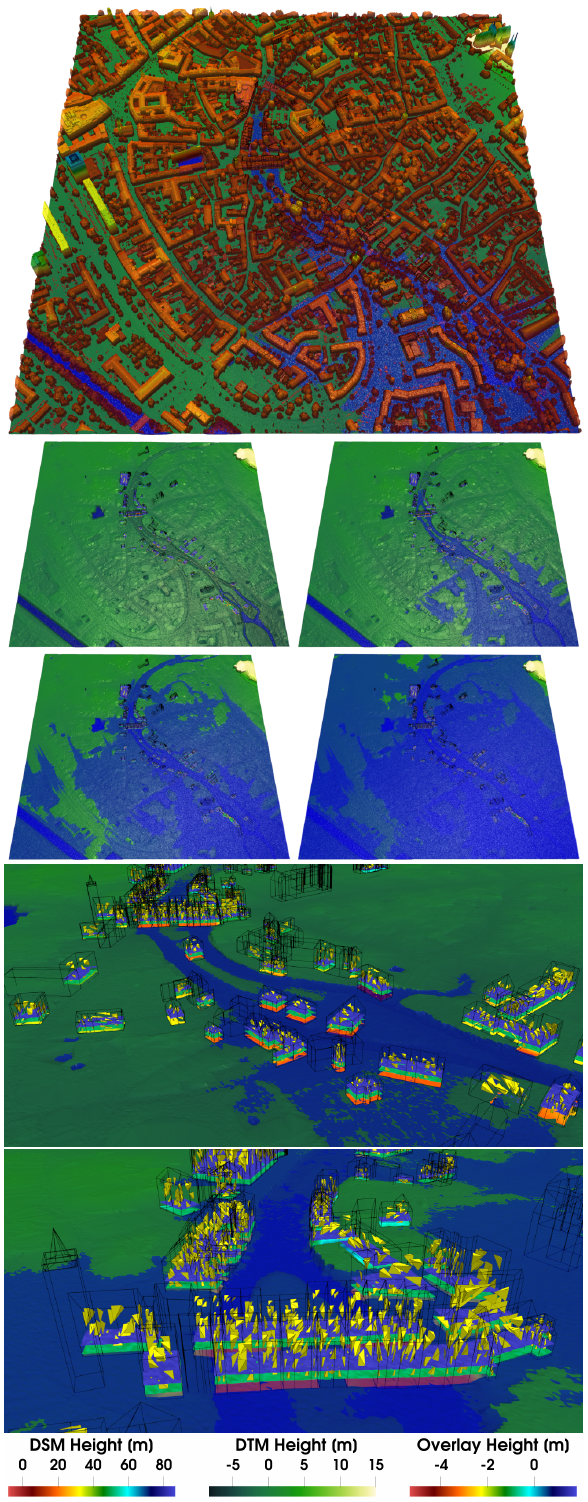
Figure 8. Digital Surface Model (DSM, coloured by height), Digital Terrain Model (DTM, coloured by height), CityGML (black), tetrahedralized CityGML (yellow) with shrunk tetrahedra, water surface (blue) at different times and intersection-geometries for each time (coloured by height).